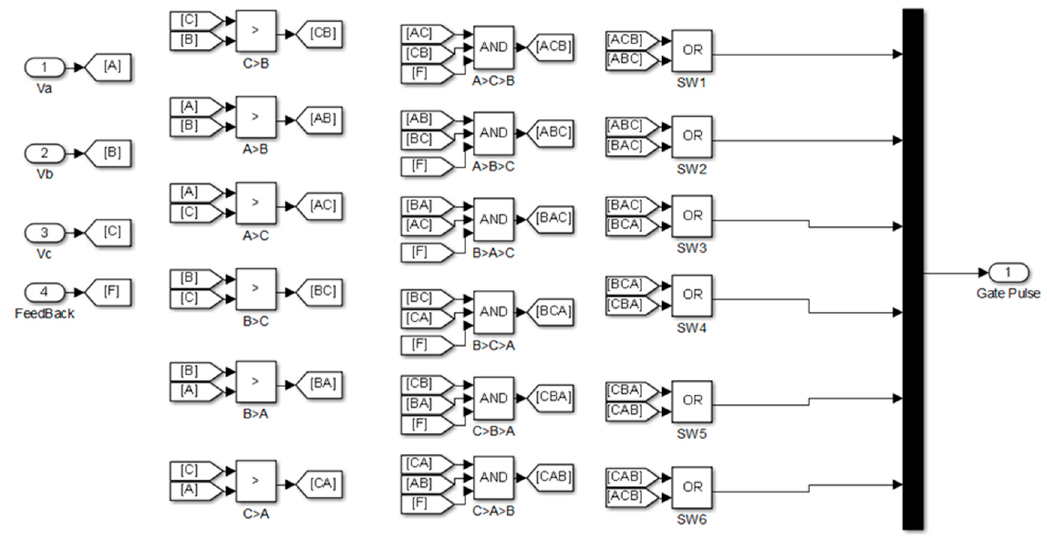
Figure 13. Algorithm used to enable the controller for simulation purposes.